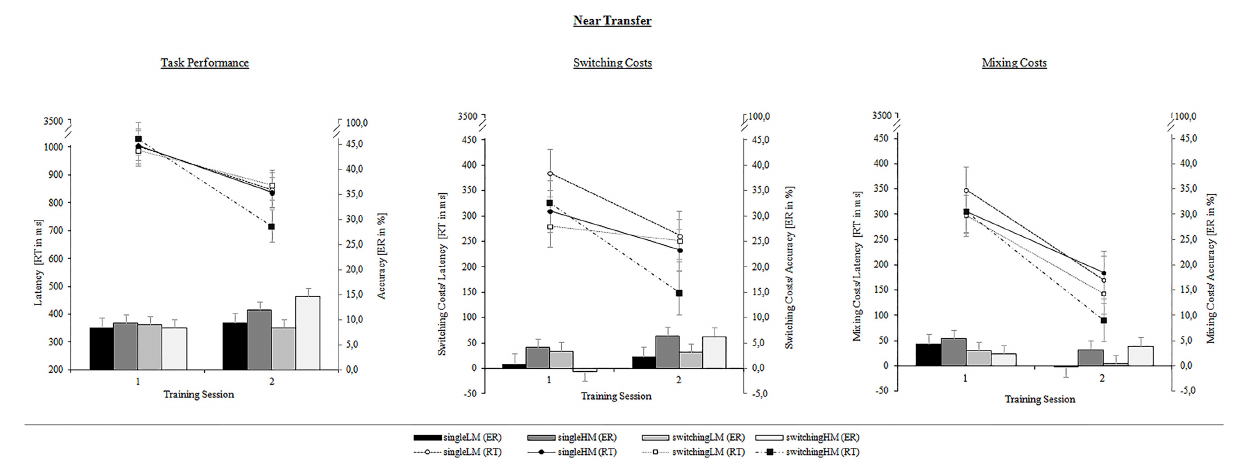
(pretest, posttest). Error bars depict SE based on the group x session interaction comparing group conditions of the respective mixed ANOVA according to Jarmasz and Hollands (2009). Note that the selected variance estimators are not suited to compare session